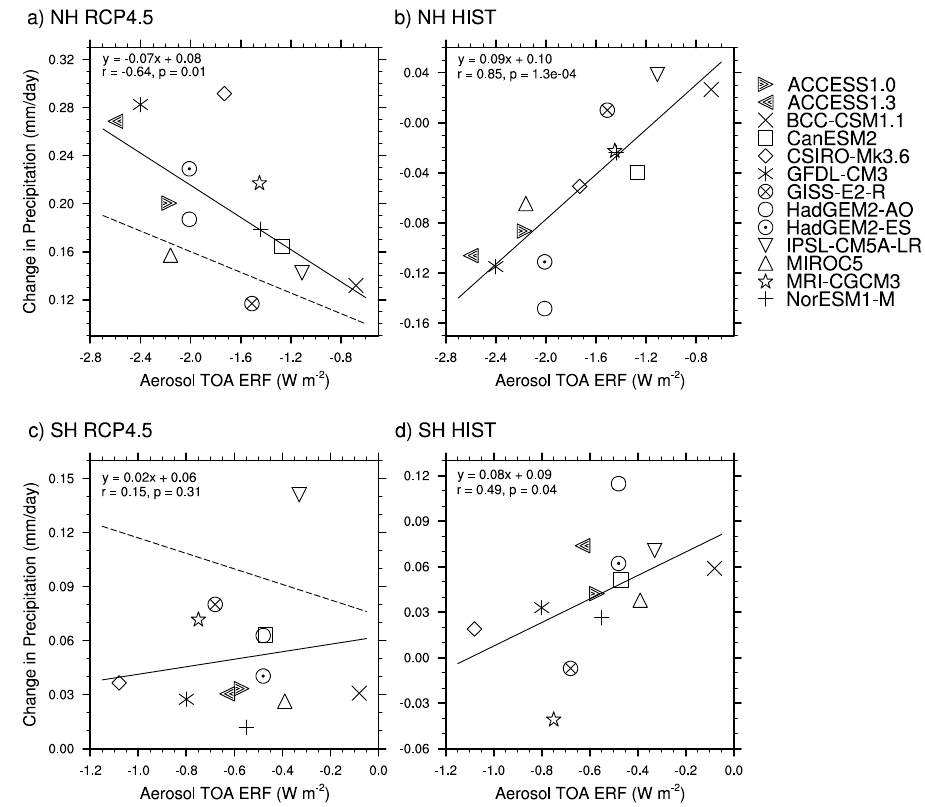
Fig. 13. Changes in hemispheric-mean precipitation from CMIP5 models plotted against (2000 relative to 1850) hemispheric-mean aerosol ERF diagnosed from fixed-SST simulations: (a) NH RCP4.5, (b) NH historical simulations, (c) SH RCP4.5, (d) SH historical simulations. Also shown in each panel are the regression line, the equation for the regression line, the correlation and the level of significance. The dashed lines in panels (a) and (c) reproduce the regression line from Fig. 11a, namely, the relation between projected changes in global-mean precipitation and global-mean aerosol